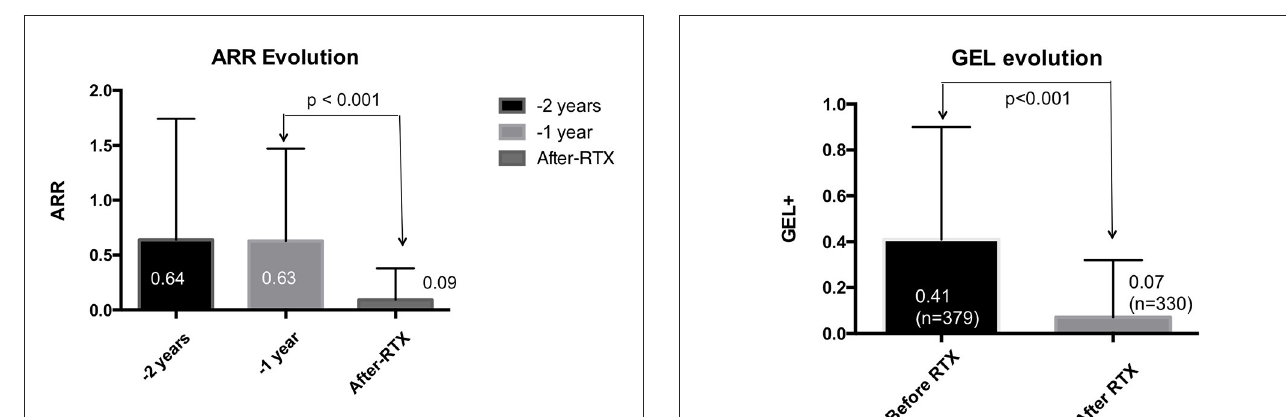
FIGURE1 Annualized relapse rate, before (2 years and 1 year) and after starting rituximab. Data for the entire series are shown. A significant reduction in ARR was observed after rituximab infusion. ARR, annualized relapsing rate.